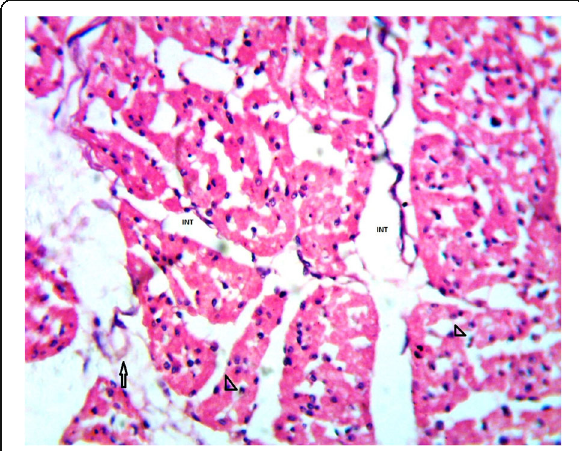
Fig. 1 Heart section of broiler chicken fed 0.0% of PCHM-inclusive diet showing normal histological structure of the myocardium which composed of the cardiac muscle with peripherally placed nucleus (arrow head) separated by a defined interstitium that is free from inflammatory cells. The cardiac vessels (arrow) appear normal. (H&E × 400)